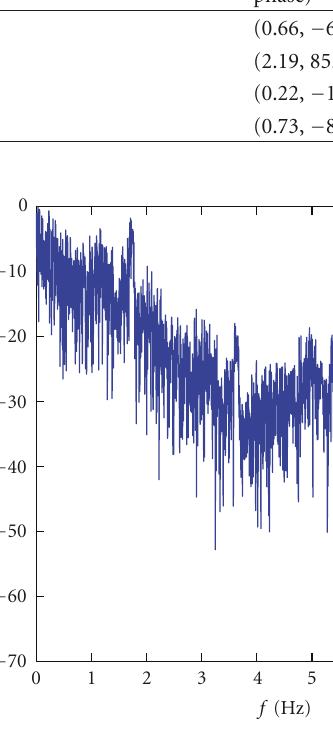
Figure 5: Positions of the 103 transmitters and of the receiver and of the target trajectory.